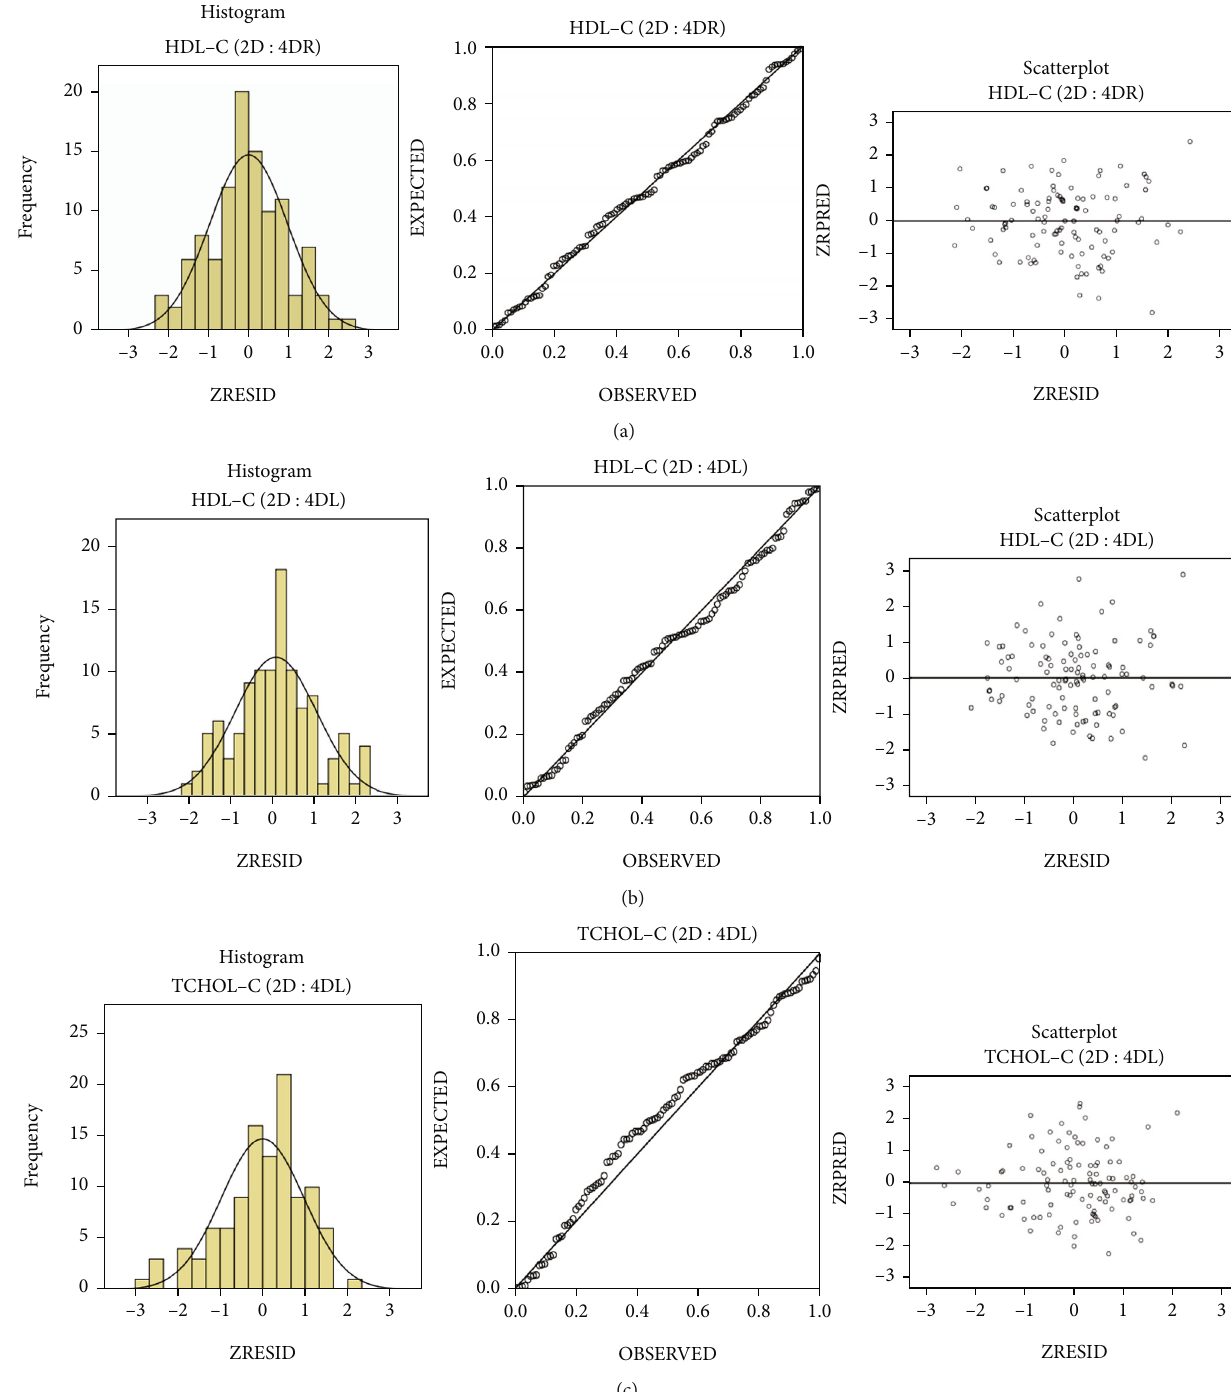
Figure 2: Assumption testing of linear regression. Histogram for normality (column 2), probability-probability plot (P-P plot) for linearity (column 3) and residual versus predicted value scatter plot for homoscedasticity (column